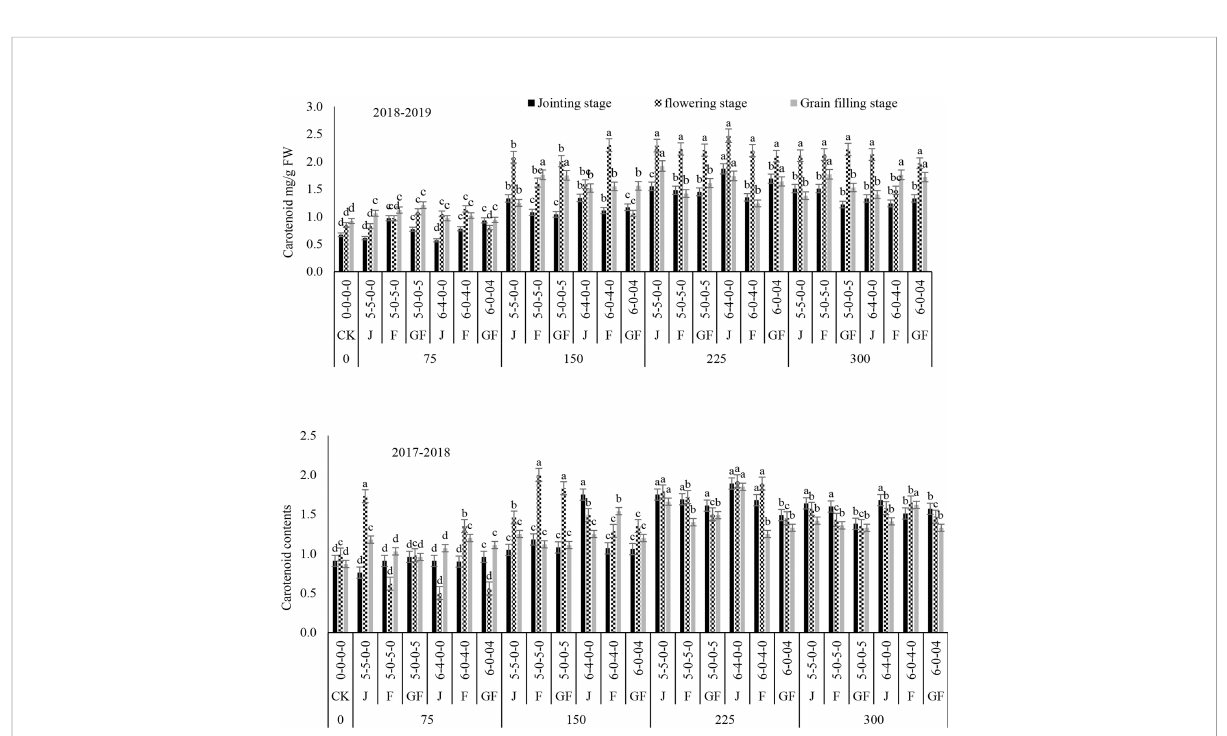
FIGURE 10 Effect of nitrogen fertilizer management on the carotenoid content of winter wheat. JS , jointing stage; FS , fl owering stage; GF , grain fi lling stage. Different letters in above bars indicate a signi fi cant difference